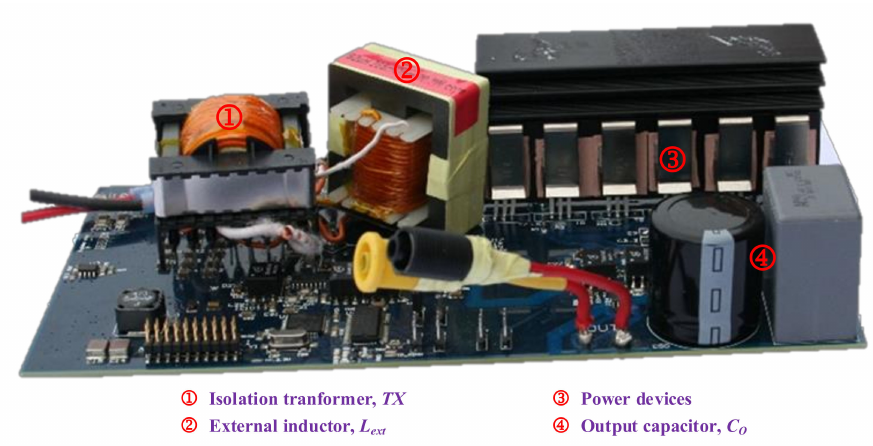
Figure 11. Experimental setup in the laboratory. Table 2. Setup parameters and